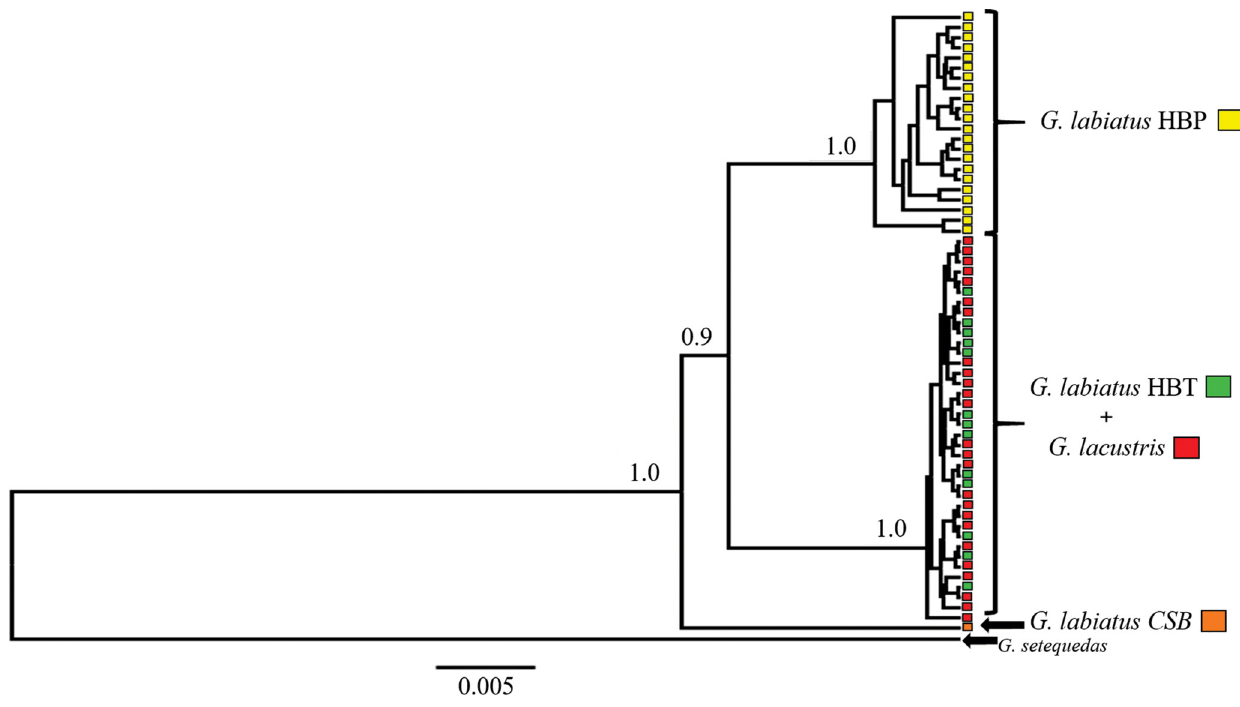
FIGURE 4 | MtDNA genealogy for the individuals analyzed. The values above the nodes correspond to the posterior probability of each clade. Only the values for the clades discussed in the text were presented. The colors represent the analyzed populations, according to the